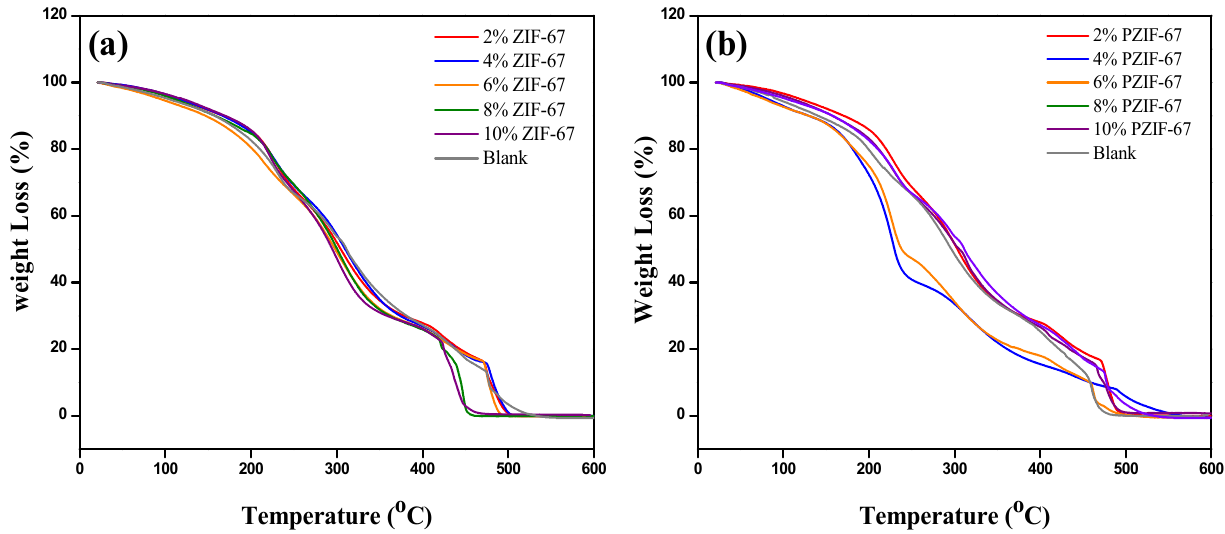
Figure 5. Weight loss analysis by TGA of PVA/starch nanocomposite films with various amounts of ( a ) ZIF-67 and ( b ) Pyrolyzed ZIF-67.